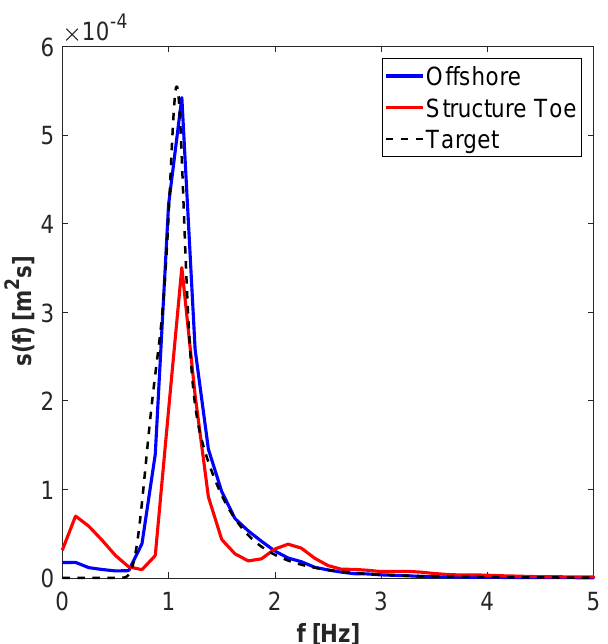
Figure 4. Measured spectra at different locations in the wave flume for TS 01 conditions generated by the wave paddle.